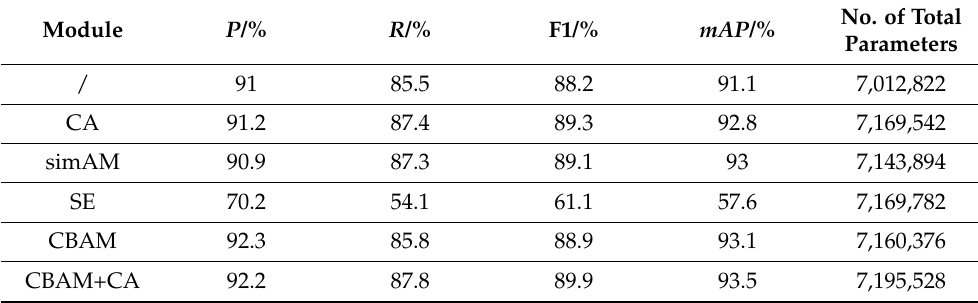
Table 3. Comparison of different attention mechanism modules.